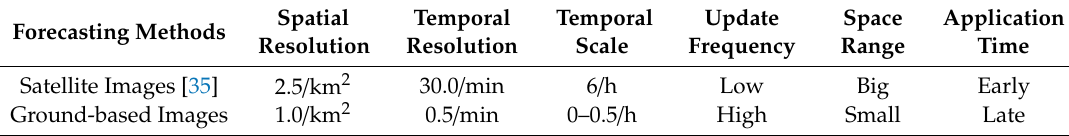
Table 1. A comparison between satellite images based and sky images based forecasting models